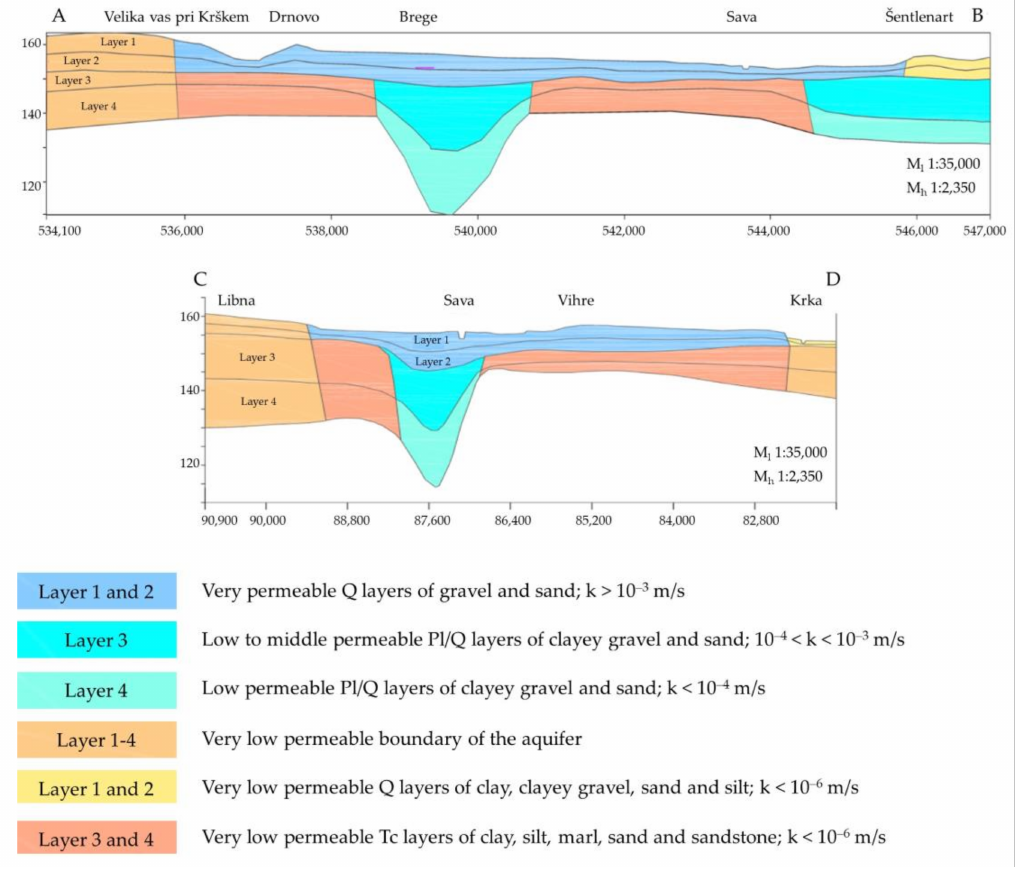
Figure 2. Cross sections ( A , B ) and ( C , D ) of the hydrogeological structure of the Krško field and Vrbina aquifer (modified after [3]; further information can be found in Figure